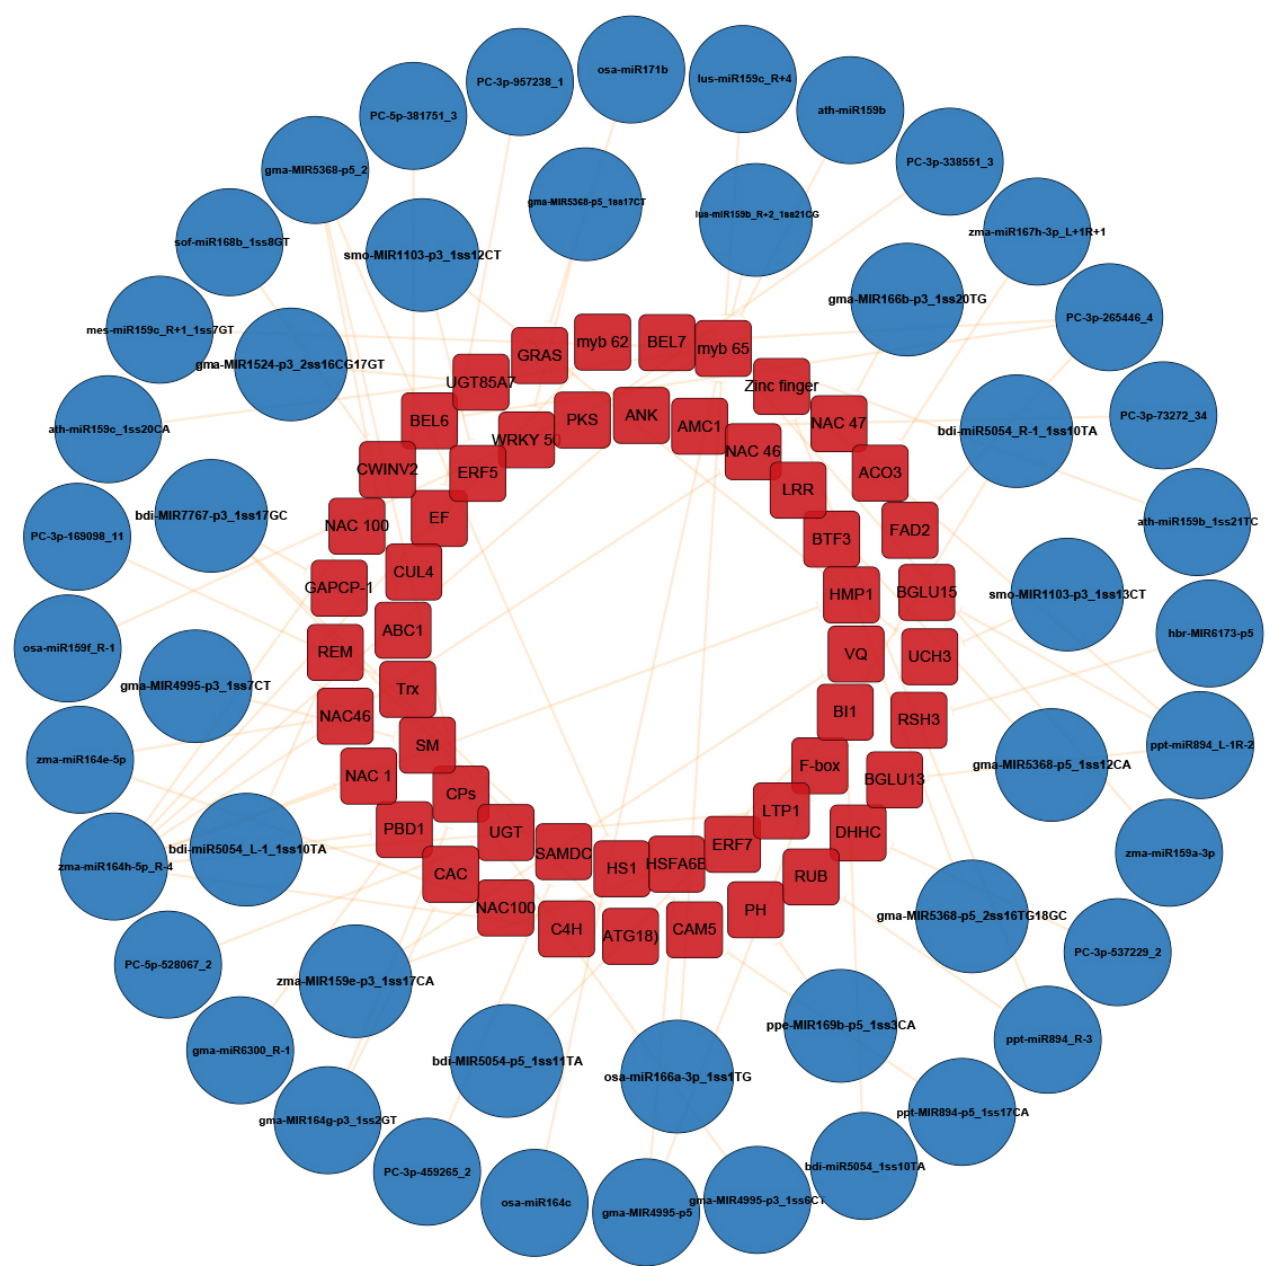
Figure 7. An interaction network indicating the relationship between miRNAs associated with the disease resistance of maize to C. lunata and their corresponding target genes. The blue circles represent the miRNAs and red rectangles represent the target genes. The characters in the red rectangles stand for the abbreviation of target genes showing in Table S13.